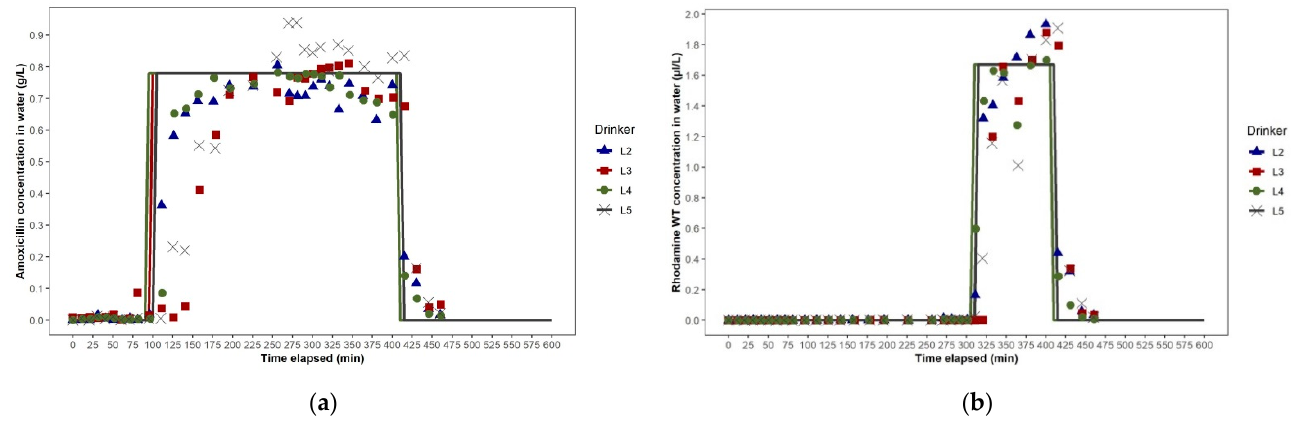
Figure 6. Study 1b dosing event in Building A: ( a ) amoxicillin concentration—time plots for drinkers L2, L3, L4 and L5, as predicted using EPANET (lines) and as observed (points), ( b ) rhodamine WT concentration—time plots for drinkers L2, L3, L4 and L5, as predicted using EPANET (lines) and as observed (points).